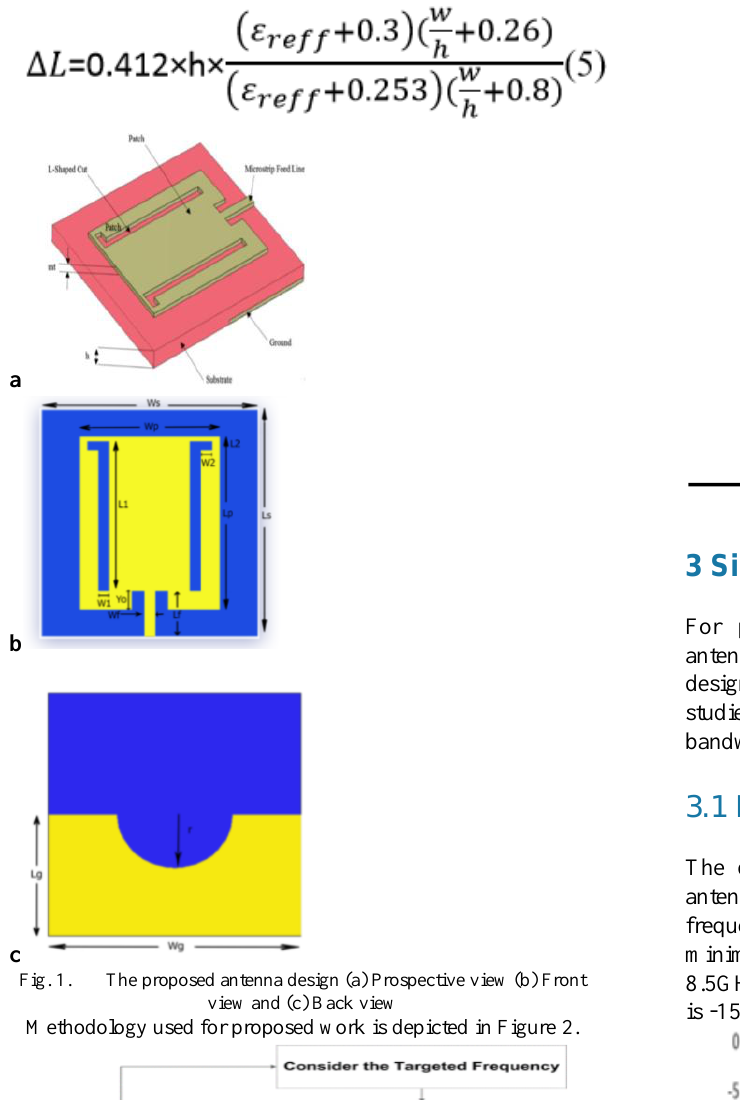
Fig. 1. The proposed antenna design (a) Prospective view (b) Front view and (c) Back view Methodology used for proposed work is depicted in Figure 2.